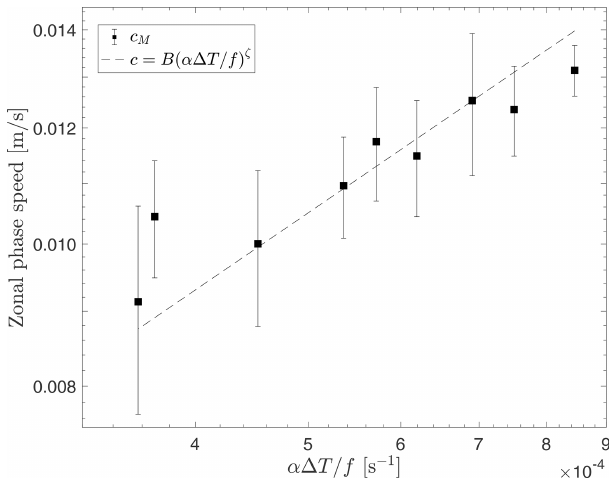
Figure 5. Log–log plot of the zonal phase speed c M of the baro- clinic wavefront for decreasing (cid:49)T calculated from φ – t diagrams at a fixed radius R d = 0 . 087m. The dashed line c is calculated from Eq. (4) with ζ = 0 . 55.